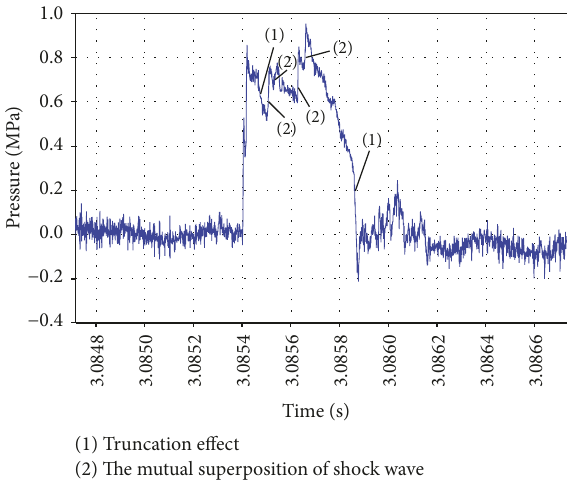
Figure 3: Typical pressure time history curve of underwater shock